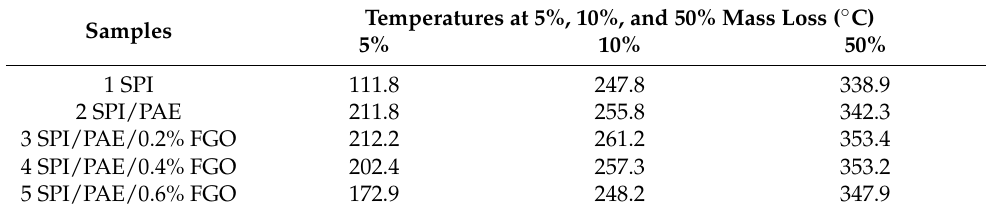
Table 2. The values of temperatures at 5%, 10%, and 50% of mass loss of different adhesives. Samples